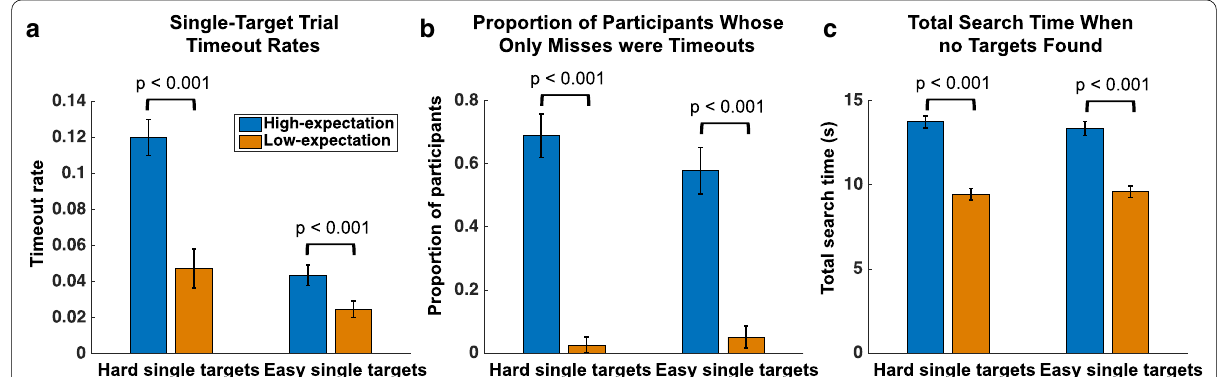
Fig. 2 Analysis of timeout rates and search termination times for the high-expectation (blue) and low-expectation (orange) groups. Reported p -values are from planned pairwise comparisons. All error bars depict the S.E.M. a Timeout rates for hard and easy single-target trials, p -values from Mann–Whitney U tests. b The proportion of participants in each group whose misses were entirely due to timeouts for hard and easy single-target trials, p -values from chi-squared tests. c Total search times on hard and easy single-target trials where the participants failed to find the target, p -values from Mann–Whitney U